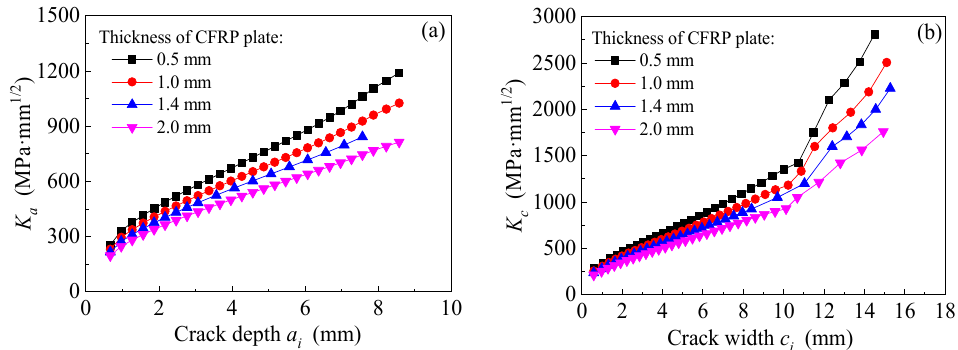
Figure 23. Effect of stiffness of CFRP plate on the K ‐ values at crack tip of the corroded steel plate strengthened with CFRP plates: ( a ) K a vs. crack depth a i and ( b ) K c vs. crack width c i .